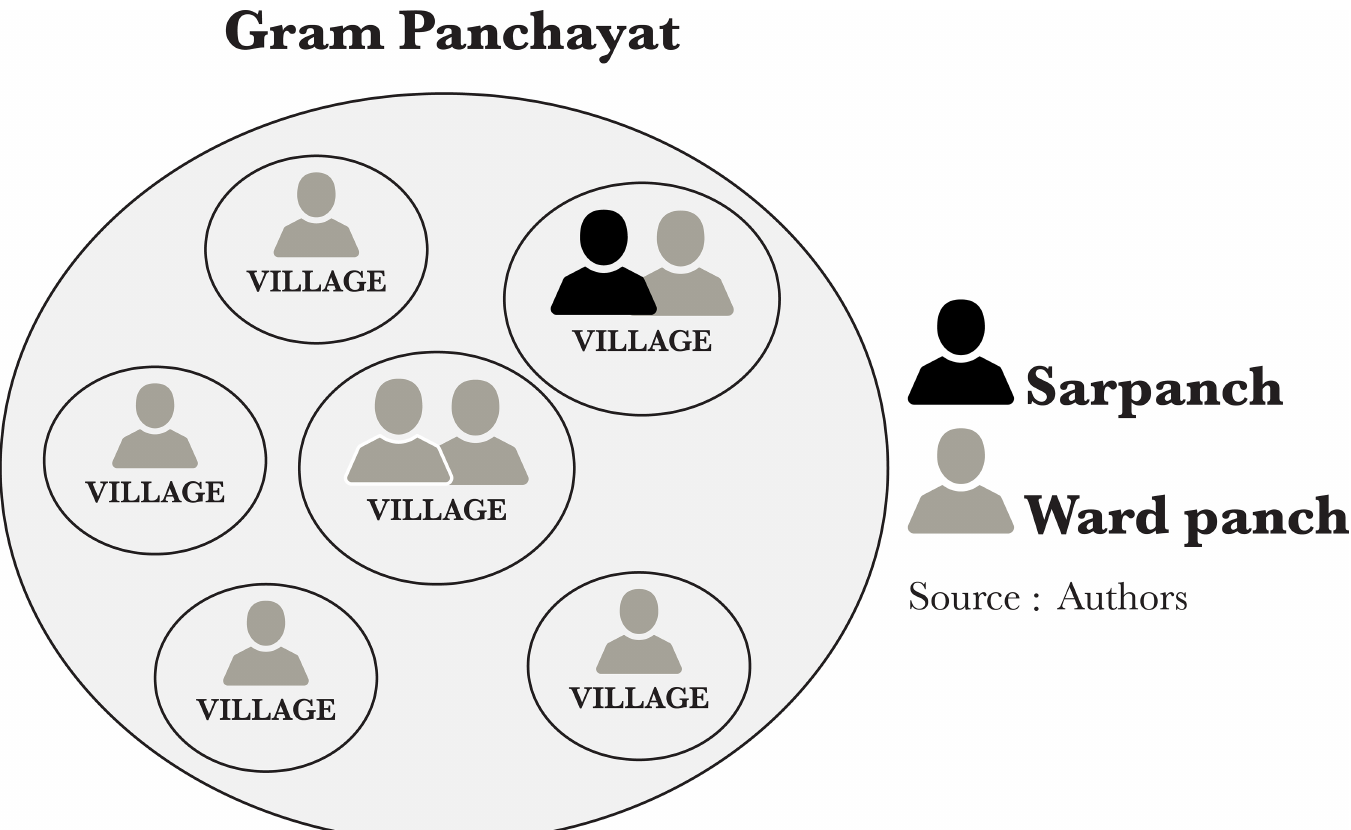
Fig 1. Diagram of the gram panchayat (local elected government)